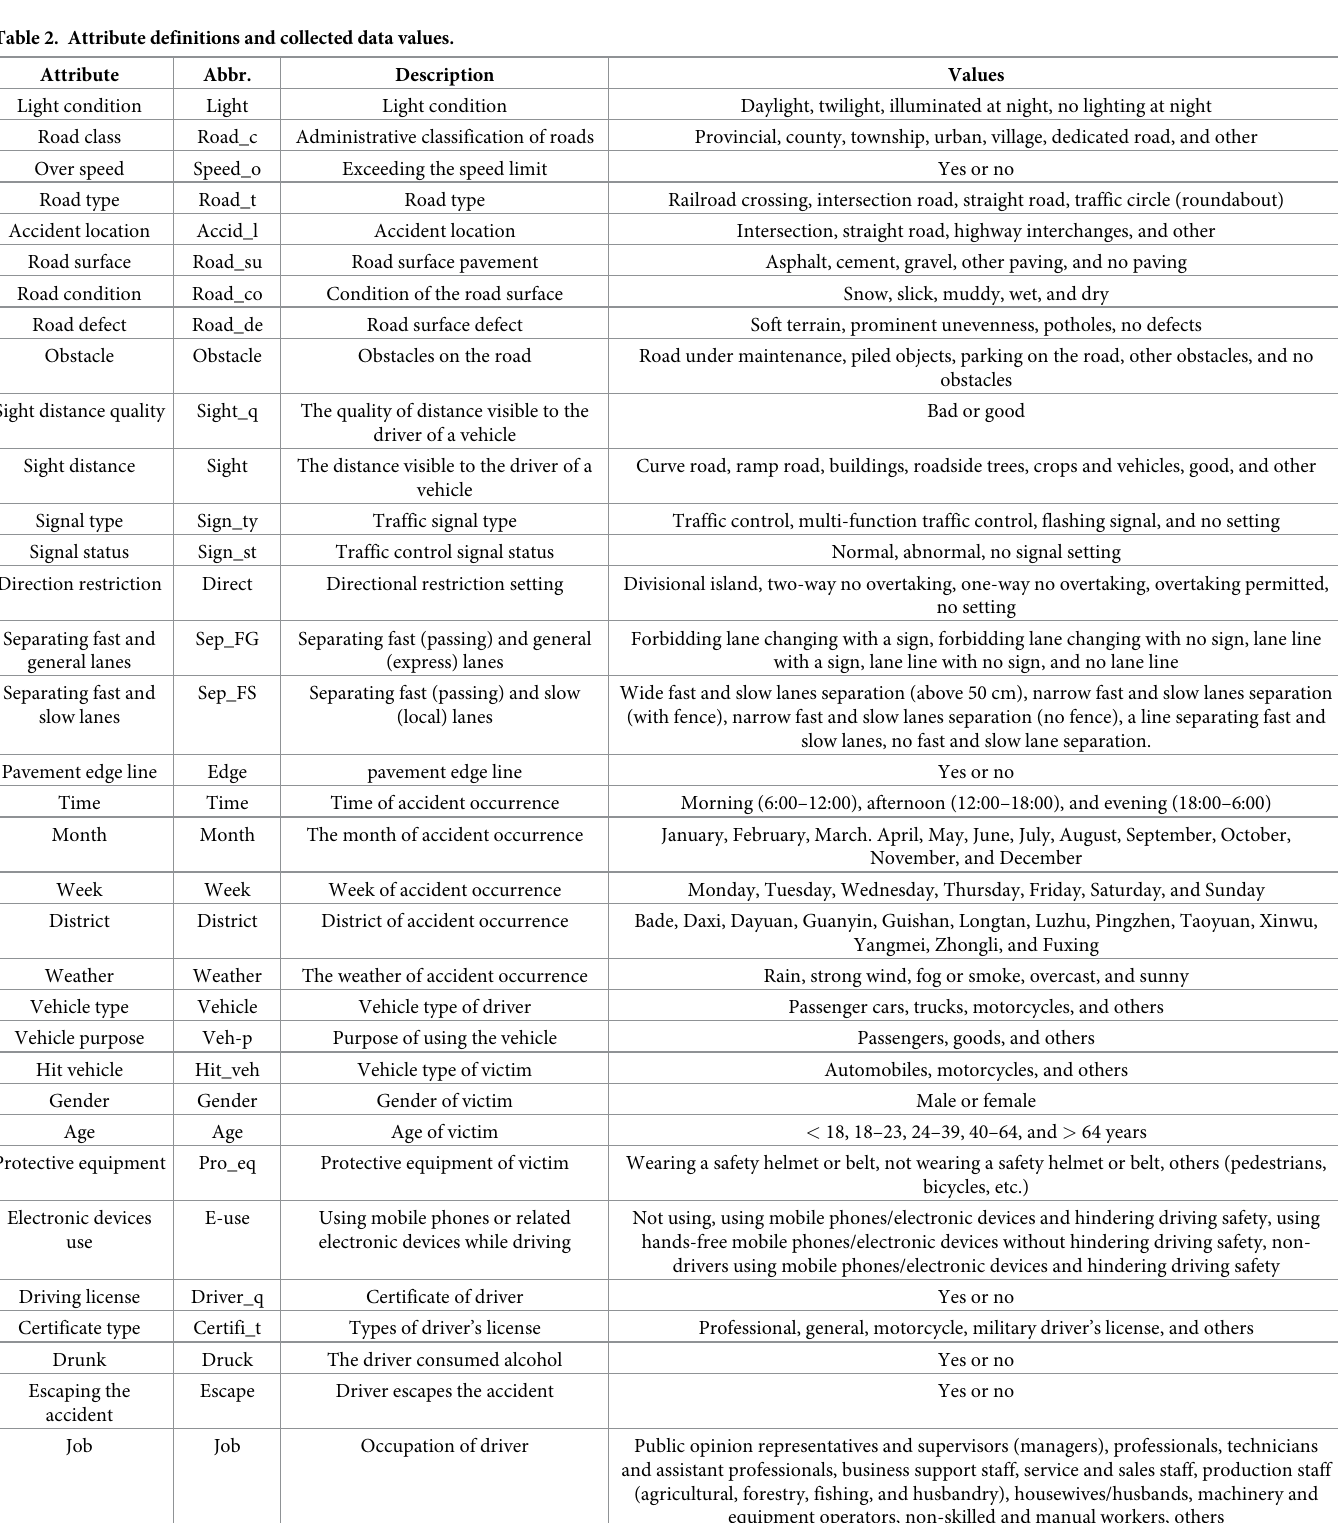
Table 2. Attribute definitions and collected data